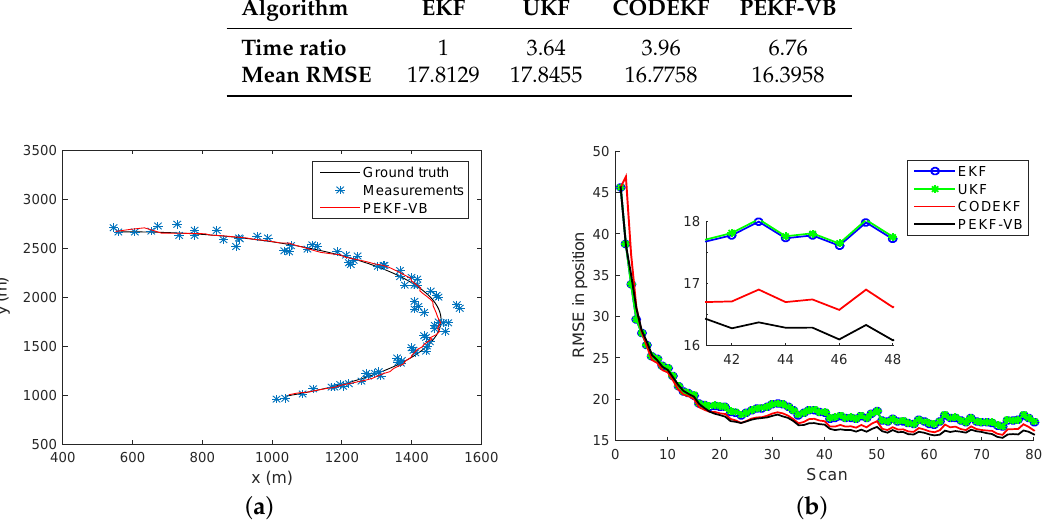
Figure 2. Tracking with a CT model ( a ) Trajectory, measurements and estimation ( b ) RMSE obtained by EKF, UKF, CODEKF and PEKF-VB.